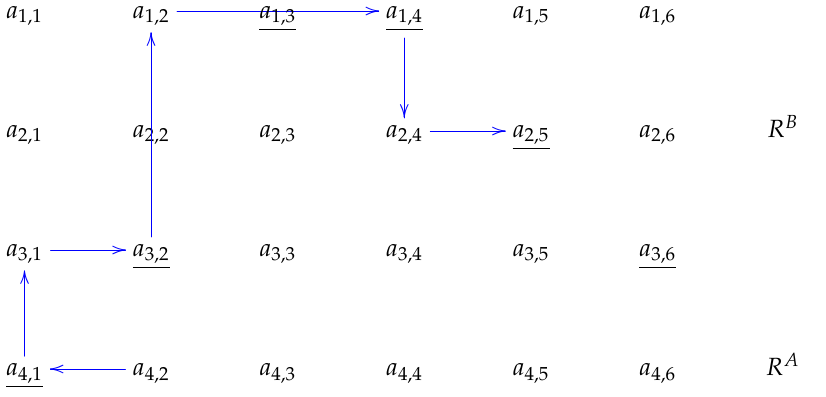
Figure 4. Helix defined by the word W P = ABBAABBA . Numbers a i , j denote the pivoting entries.